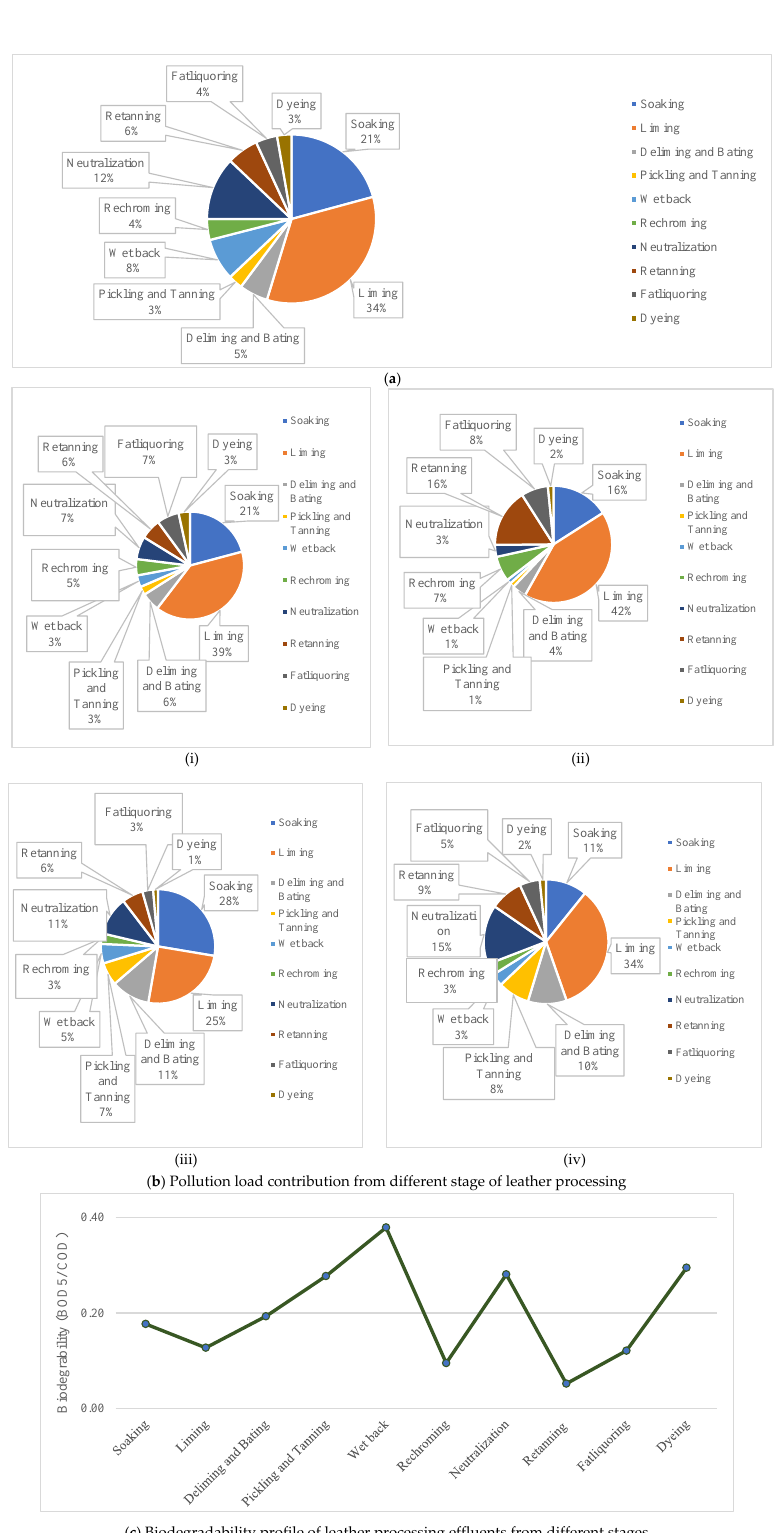
Figure 6. Volume and characteristics of effluent generated by different stages of leather processing. ( a ) Effluent generation from leather processing stages. ( b ) Pollution load contribution from different stages of leather processing: ( i ) BOD, ( ii ) COD, ( iii ) TDS and ( iv ) TSS. ( c ) Biodegradability profile of leather processing effluents from different stages.